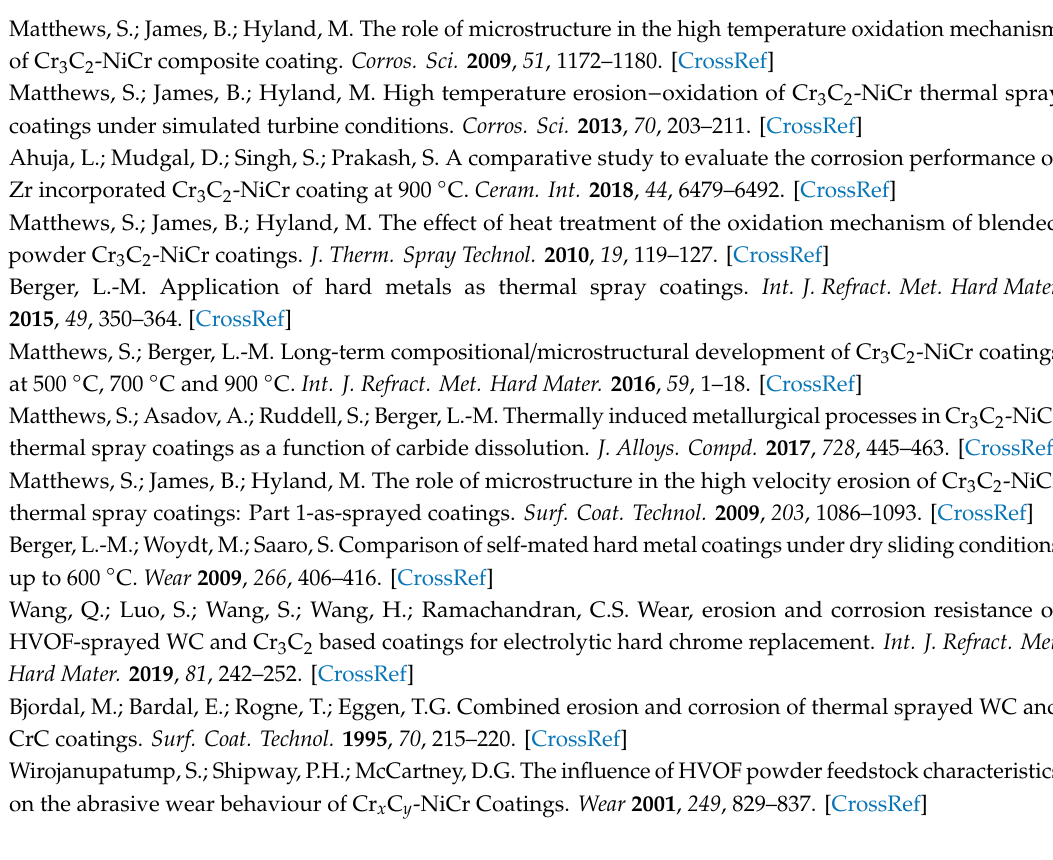
Figure S1: (a) SEM micrograph and (b) XRD pattern of the feedstock powder used for HVAF, Figure S2: Rietveld refinement of the XRD pattern of the 192 h-annealed coating after removal the